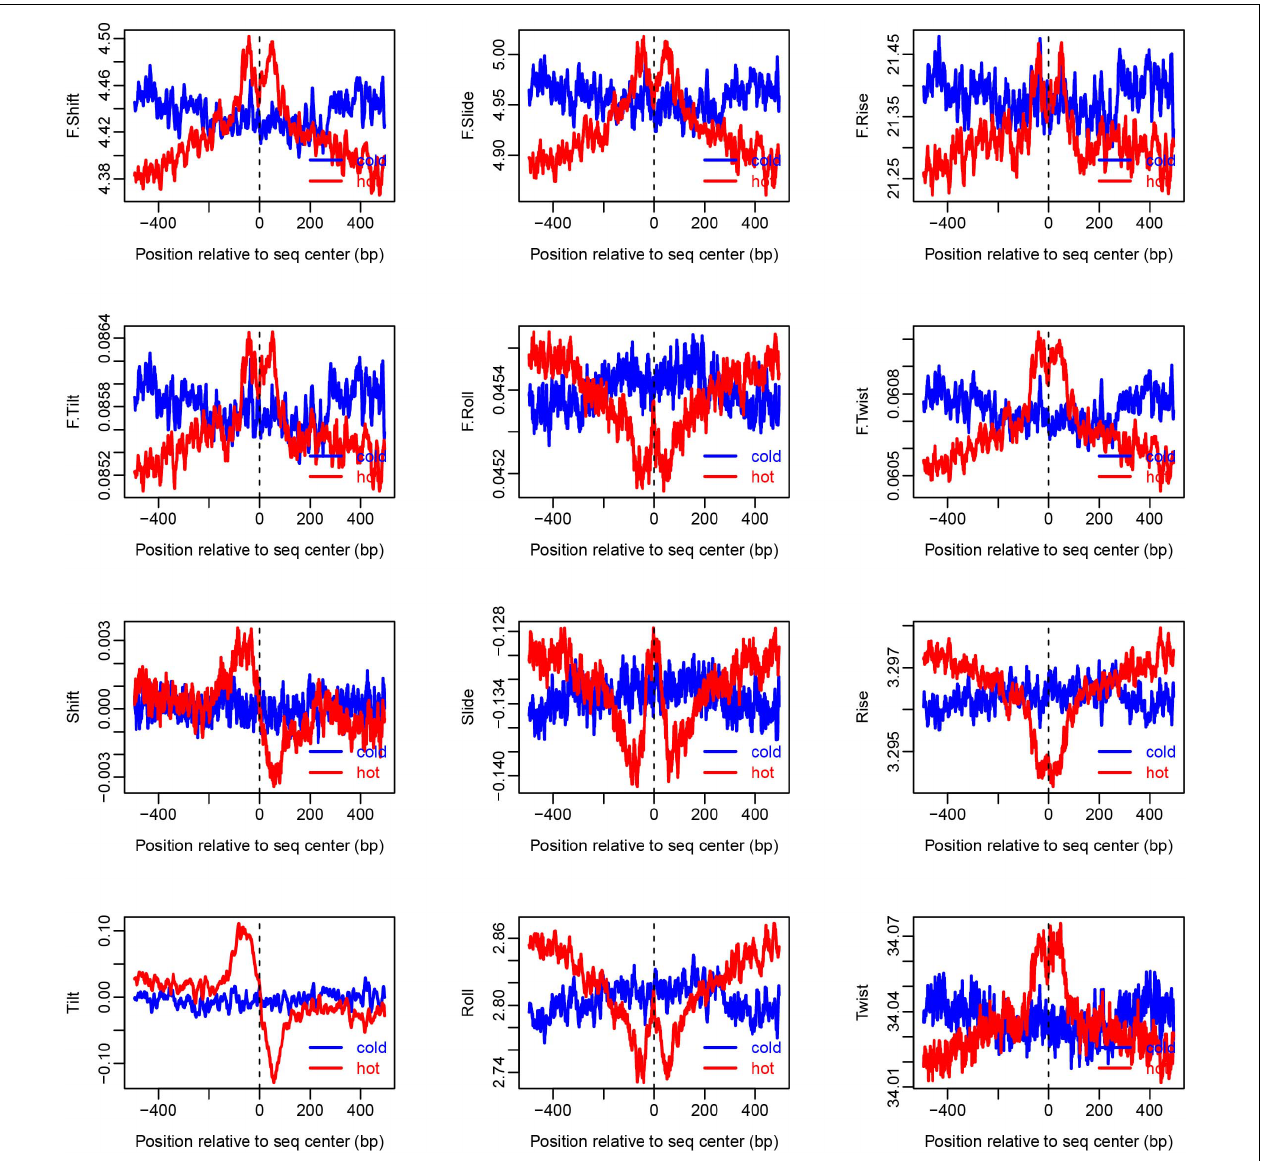
FIGURE 4 | Distribution of DNA base-pair-step parameters at hot/cold spots. The plots were smoothed with a 10-bp moving average. The base-pair-step parameters were taken from Liu et al., 2021 ( Supplementary Table 2